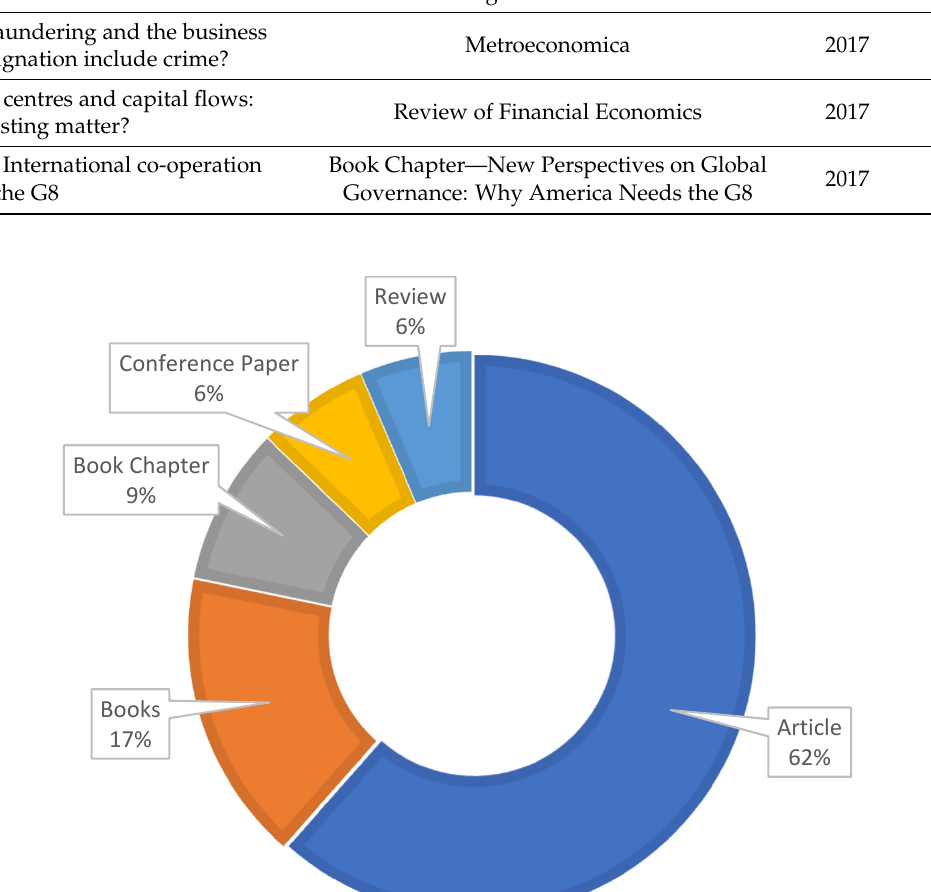
Figure 7. Publication source distribution.